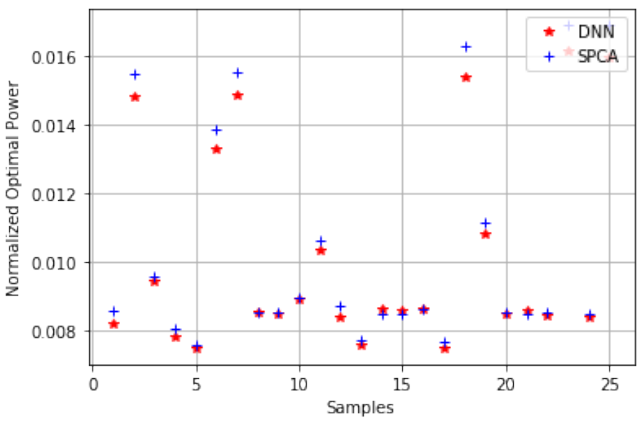
Figure 4. Optimal power samples from the DNN and SPCA.